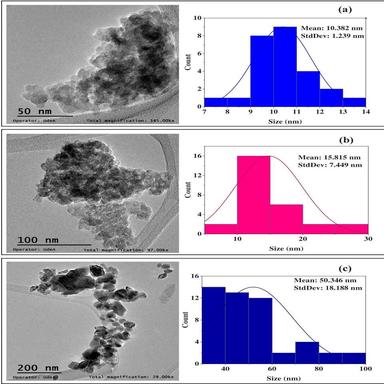
TEM images and particle size distribution: (a) TC0; (b) TC2; (c) TC7.